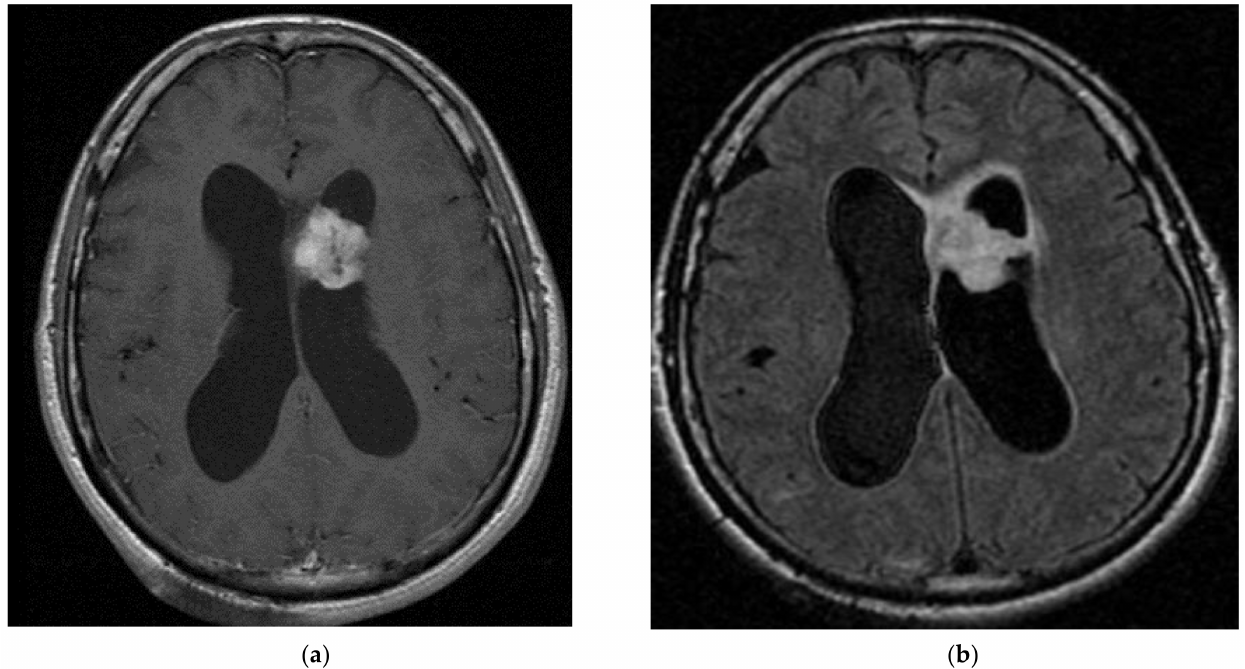
Figure 4. Young male aged 38 years old with subependymal giant cell astrocytoma (SEGA) discov- ered on a systematic MRI. Due to mTOR inhibitor discontinuation, a slowly progressive disease requiring surgical resection. No disease activity after surgery. Axial view, ( a ) T1-weighted image after gadolinium infusion; ( b ) Flair-weighted